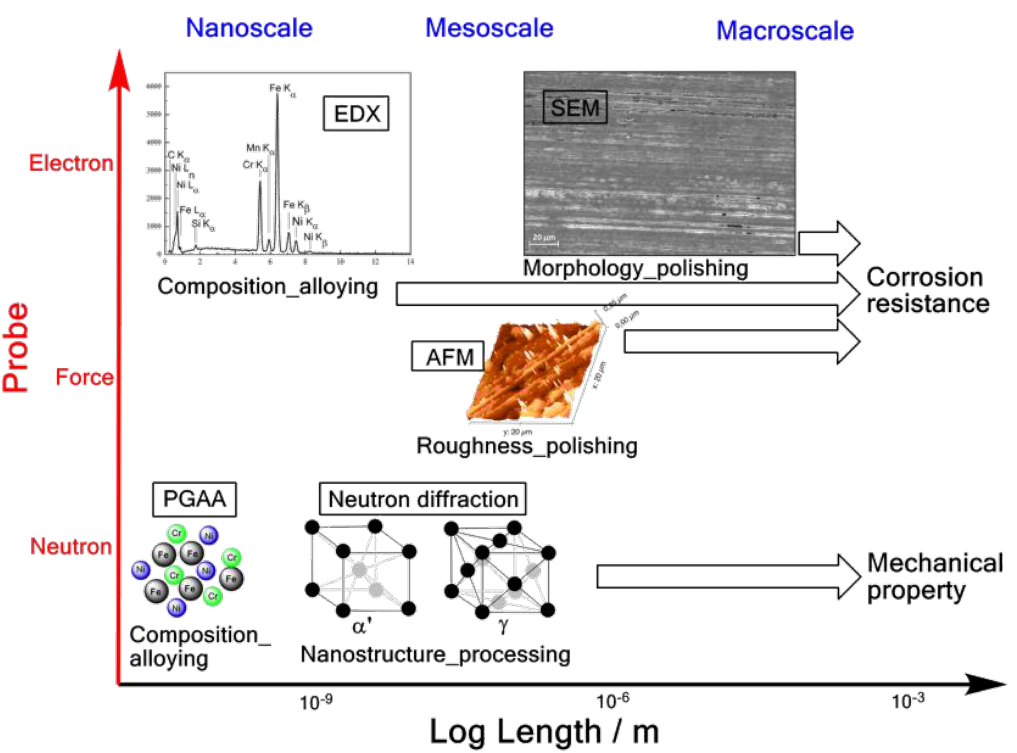
Figure 1. Illustration of the nano- through meso-scale properties and their respective determining factor from the material production process, afforded in this work with different techniques, applying three probes (i.e., neutron, force and electron).